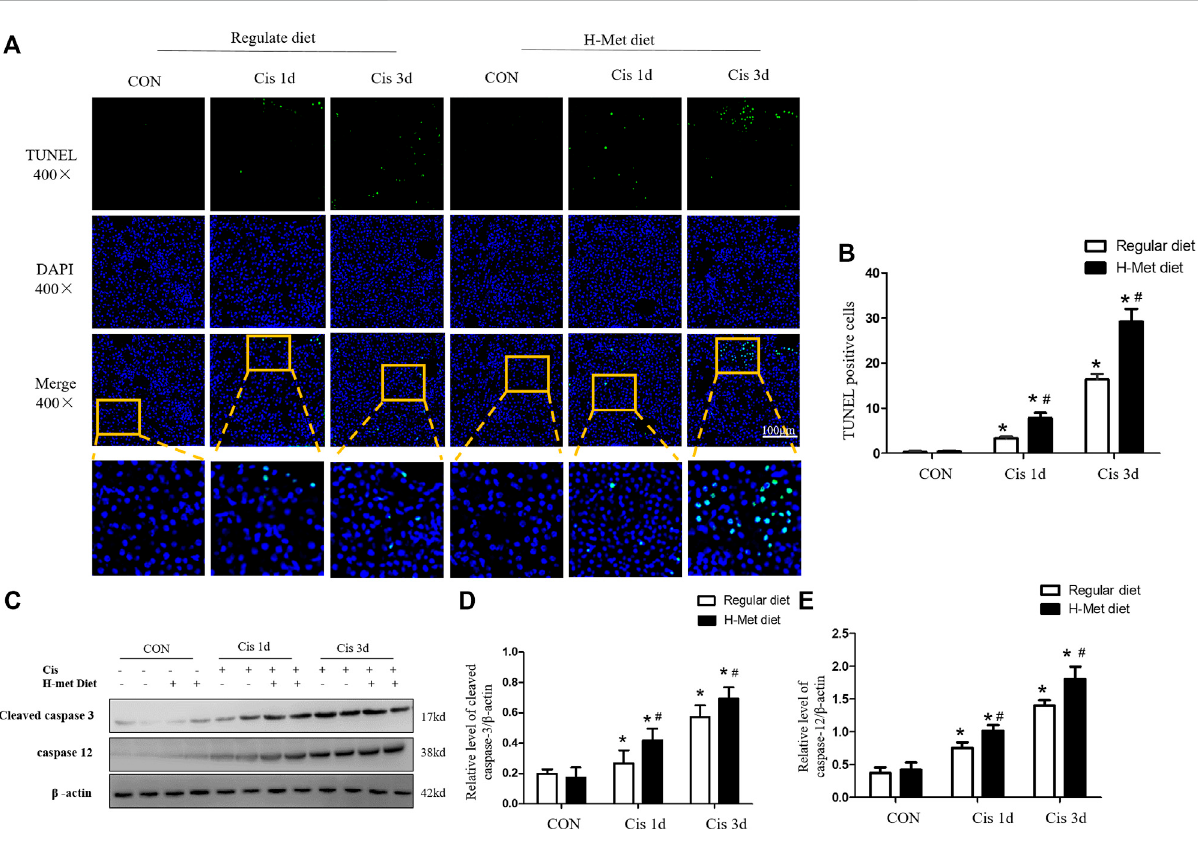
FIGURE 3 Hyperhomocysteinemia aggravates cisplatin-induced renal tubular epithelial cell apoptosis in mice. (A) Representative micrographs show the viability of tubular cell detected by TUNEL staining after cisplatin injection at days 1 and 3. (B) Quantitative determination of TUNEL-positive tubular cellsaftercisplatininjection(scalebar,100 μ m;Inreviewmagni fi cation,×400). (C – E) Westernblotanalysisofproteinlevelofcleavedcaspase-3and caspase 12 in kidney after cisplatin injection. Data are expressed as mean ± SD, n = 5 – 7 per group. * p < 0.05 versus control; # p < 0.05 versus mice fed with regular